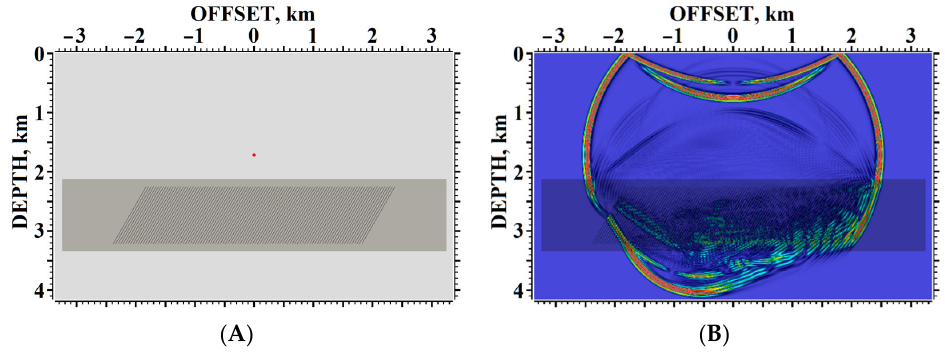
Figure 27. Example #3: ( A ) geophysical model, overlapping curvilinear mesh, a point source is marked by the red dot; ( B ) velocity modulus snapshot.